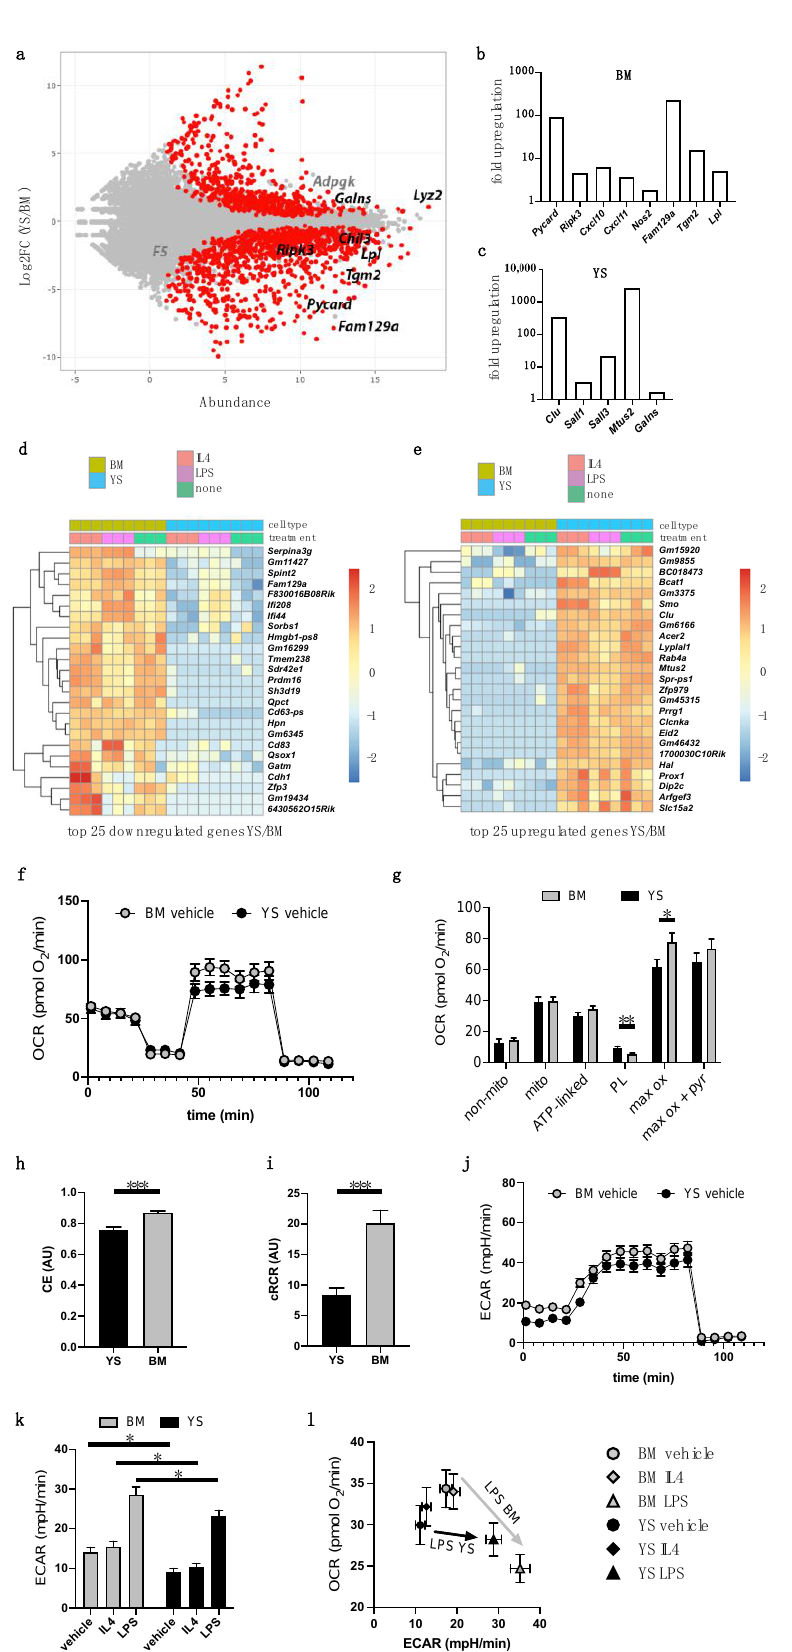
Figure 3. Transcriptome and extracellular flux analysis. ( a – e ) RNA expression analysis of